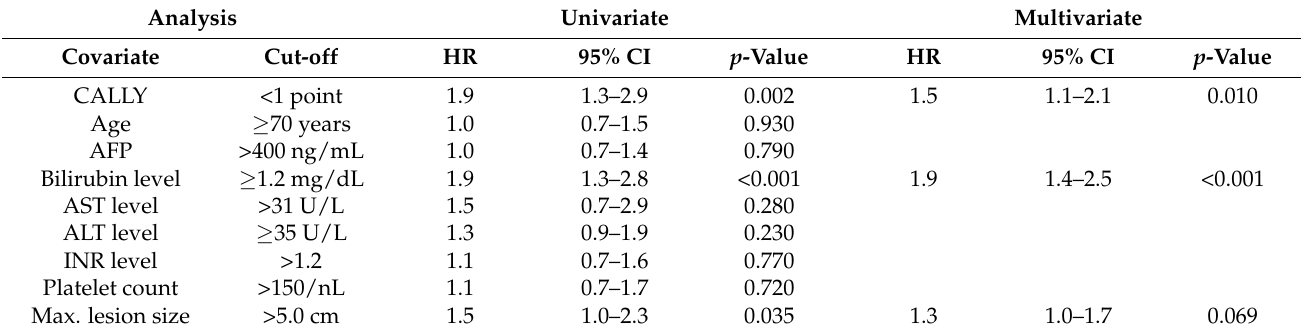
Table 3. Univariate and multivariate analysis results for patients classified as BCLC